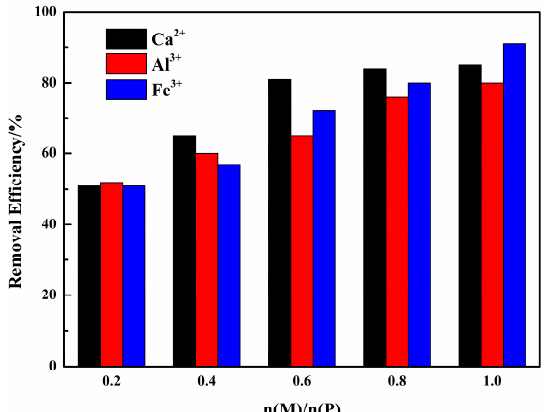
Figure 9. Phosphorous removal experiments ((P) = 0.01 mol/L, n(Ca)/n(P) = 0.2–1, n(Al)/n(P) = 0.2–1, n(Fe)/n(P) = 0.2–1).